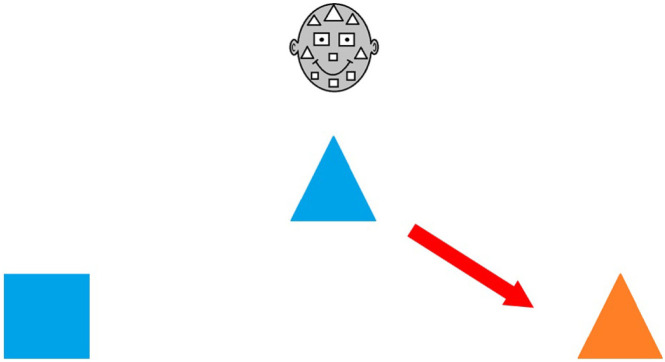
Example of a shape trial (the arrow only appeared during the instructions).